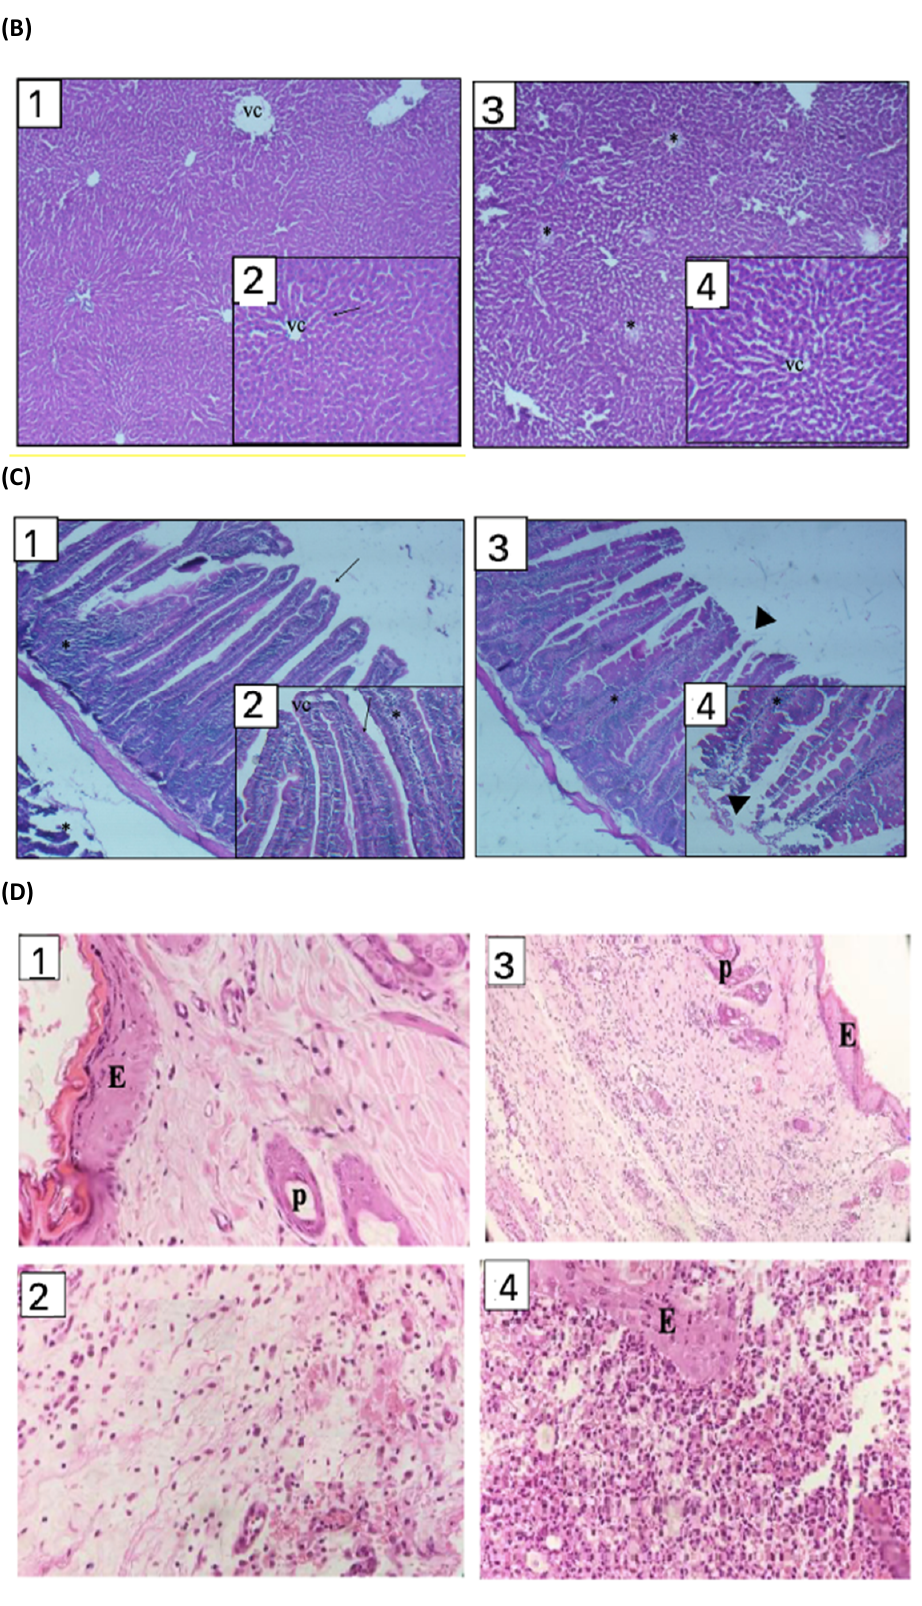
Figure 3. Box 1;2 represents IF group while Box 3;4 represents FF group. ( A )—Kidney: tp: proximal tube; g: glomerulus; arrows: tubular damage; *: proximal and distal tubular damage. ( B )—Liver: vc: centrilobular vein; arrows: hepatocytes; *: necrosis. ( C )—Duodenal segment: arrows: intestinal villi; *: inflammatory cells. ( D )—Operative Wound: E: epithelium; p: hair